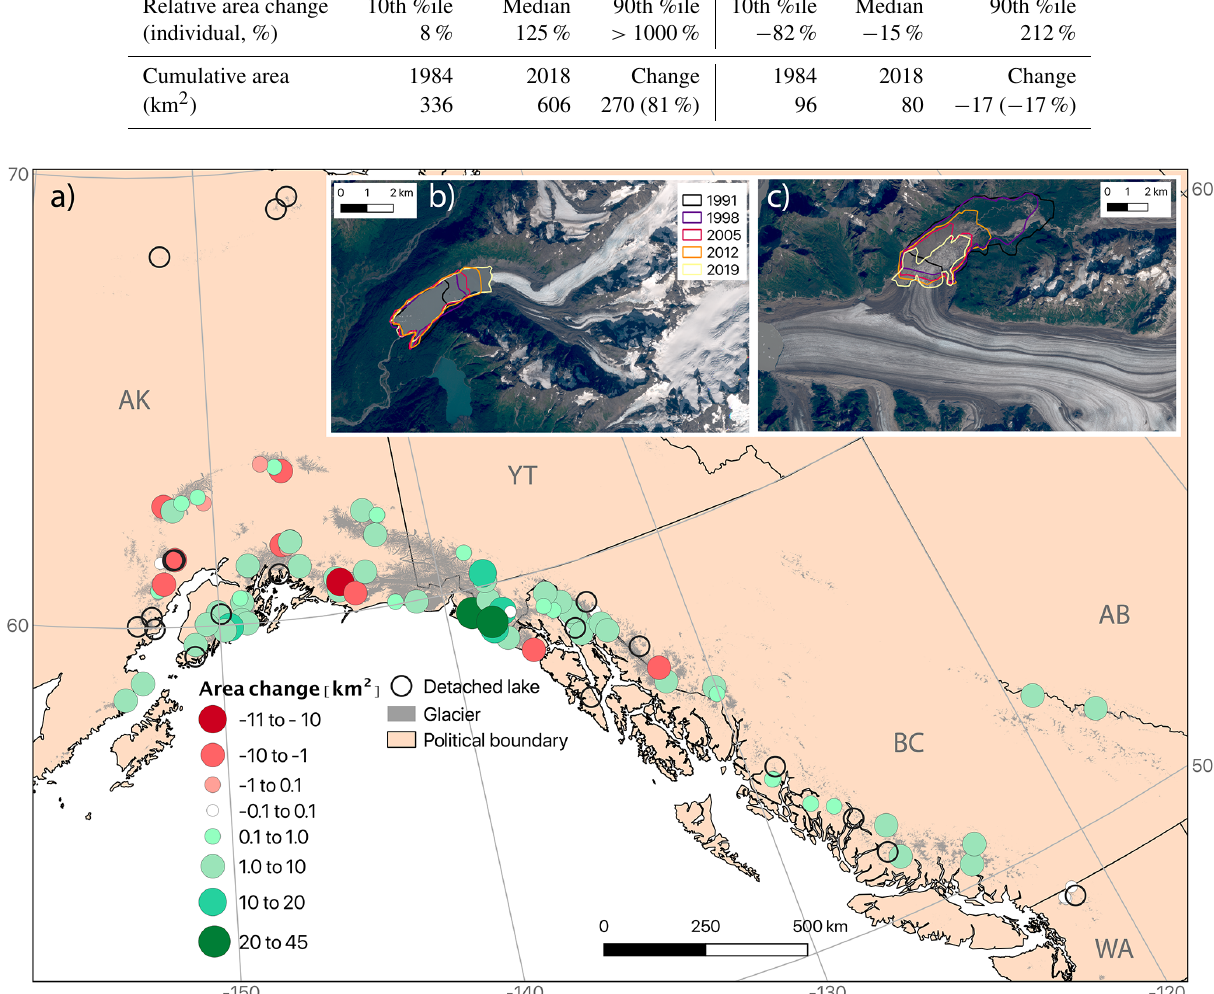
Figure 5. (a) Absolute area change for the studied ice-marginal lakes between 1984 and 2018, including both proglacial and ice-dammed lakes. Green (red) circles indicate lakes that grew (shrunk) over the study period. White circles indicate lakes that remained relatively stable (within ± 0 . 1km 2 of their initial area), while unfilled circles show lakes that detached from their associated glacier during the study period. Glacier extent is shown in gray fill (RGI Consortium, 2017), and black lines indicate political boundaries. Examples are shown of (b) a growing proglacial lake (unnamed lake downstream from Twentymile Glacier; 60.94 ◦ N, 148 . 78 ◦ W) and (c) a shrinking ice-dammed lake (Van Cleve Lake dammed by Miles Glacier; 60.70 ◦ N, 144 . 41 ◦ W). Years displayed in (b) and (c) are upper limits on a lake’s outline (e.g., a lake delineation between 1991 and 1998 will appear as a purple line). Background imagery in (b) and (c) is from Landsat 8.